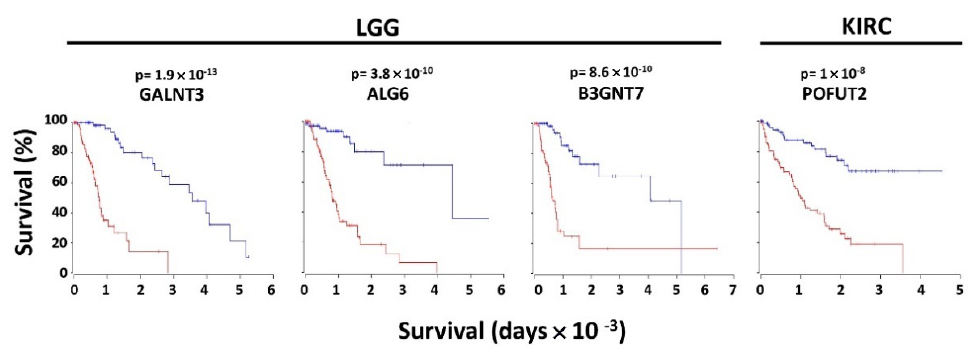
Figure 2. Kaplan–Meier of overall survival curves of the top four VHPV glycosyltransferases. Curves were determined by the Oncolnc website for the 15% higher (red) and 15% lower (blue) expressers of the four glycosyltransferases. LGG and KIRC refer to brain lower grade glioma and kidney clear cell carcinoma, respectively.